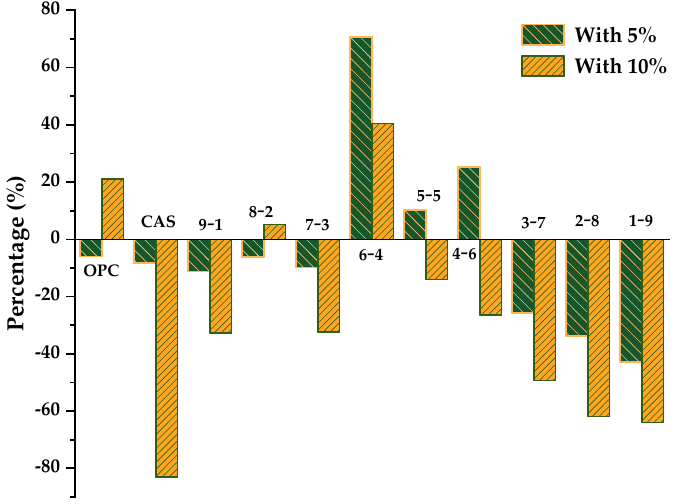
10 of 18 Figure 7. Comparison of chemical shrinkage of the OPC-CSA-CS and OPC-CSA systems at 72 h. Similarly, the effect of the OPC/CSA ratio on the chemical shrinkage of ternary binders at a fixed CS content is plotted in Figure 8. It can be seen that based on the OPC-CS blends, the incorporation of CSA promotes the chemical shrinkage of OPC-CSA-5% CS and causes the growth percentage to first increase and then decrease with the increase in the amount of CSA added. When taking CSA-CS blends as a reference, with the increase in OPC mass ratio, the percentage of reduction first decreased and then increased. A similar discussion could be conducted for the addition of 10% CS, where the opposite effect was observed.